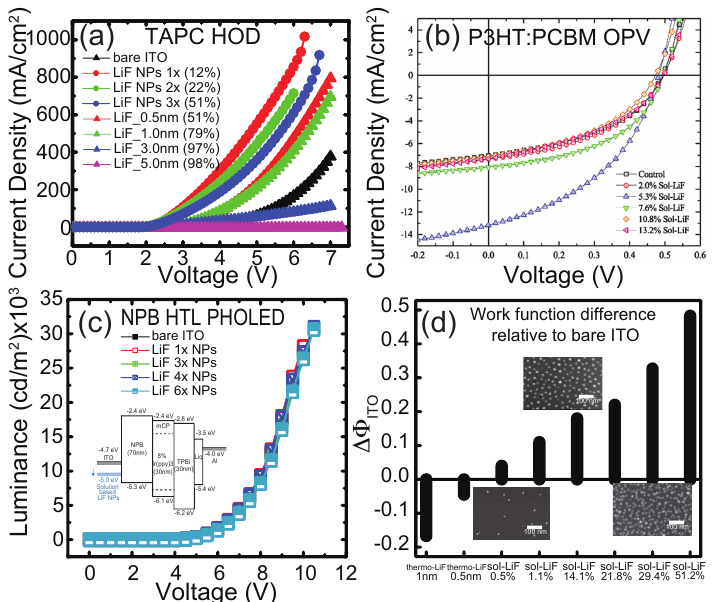
Figure 9. ( a ) Hole only current density–voltage characteristics for various coverages of LiF with a TAPC HOD with a deep HOMO level relative to ITO. Reprinted with permission from Springer Na- ture from Ref. [61] Copyright (2021). ( b ) Current density–voltage characteristic curves of P3HT:PCBM solar cells with ITO anodes modified by different sol-LiF surface coverages, a under AM1.5G il- lumination. Reprinted with permission from Springer Nature from Ref. [153] Copyright (2015). ( c ) Luminance–voltage characteristics for blue PHOLED devices with an NPB hole transport layer with varying amounts of solution deposited LiF nanoparticles. Nx represents the number of spin- coating and plasma etching cycles were performed. Reprinted with permission from Springer Nature from Ref. [61] Copyright (2021). ( d ) Work function difference for various LiF coverages relative to bare ITO. Insets show SEM images of representative LiF decorated surfaces. Note that measurements suggest that thermally evaporated LiF decreases the work function of ITO as discussed in [7], which should lead to an increasing barrier to hole injection and solution deposited LiF increases it as a function of coverage (also discussed in [6]), leading to a decreasing